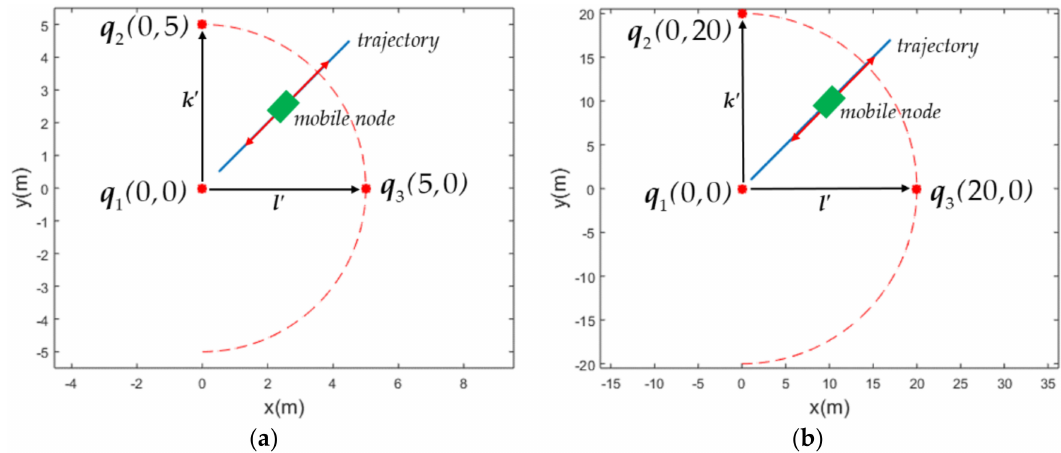
Figure 4. Projection of installation positions of anchors q mobile node. ( a ) The environment of 5 m × 5 m . ( b ) The environment of 20 m × 20 m